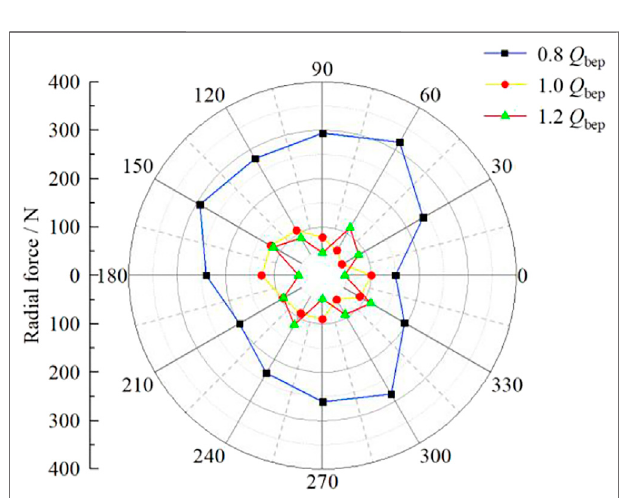
FIGURE 10 | Transient changes of radial force on the impeller at different times.